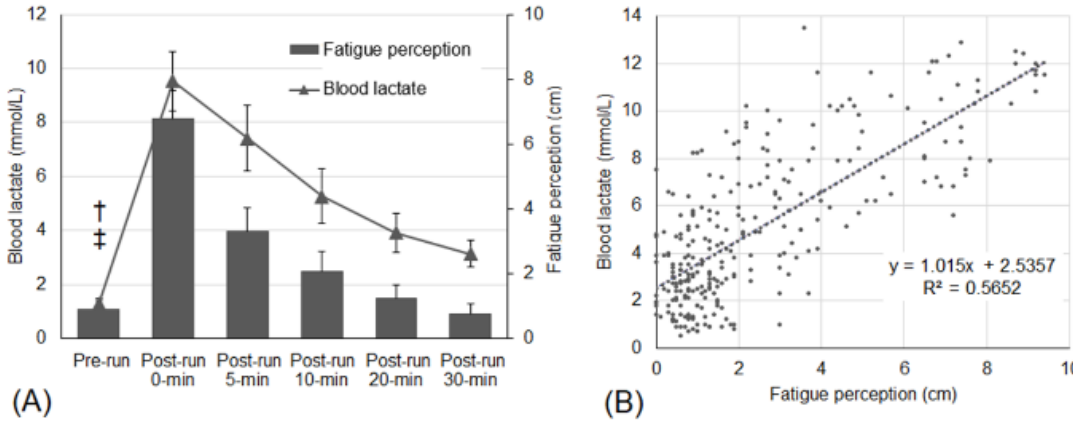
Figure 3. ( A ) Changes in blood lactate and fatigue perception regardless of conditions. Error bars are upper and lower limits of 95% confidence intervals. † Different from other time points in blood lactate ( p < 0.0001). ‡ Different from post-run 0, 5, and 10 min in fatigue perception ( p < 0.0001). ( B ) Correlation between blood lactate and fatigue perception. There is a high correlation (r = 0.75) between blood lactate and fatigue perception.